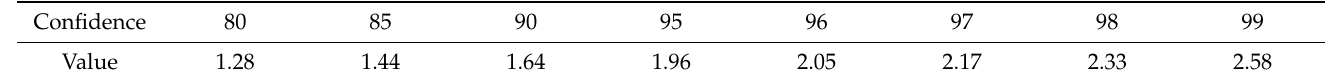
Table 1. Values of confidence